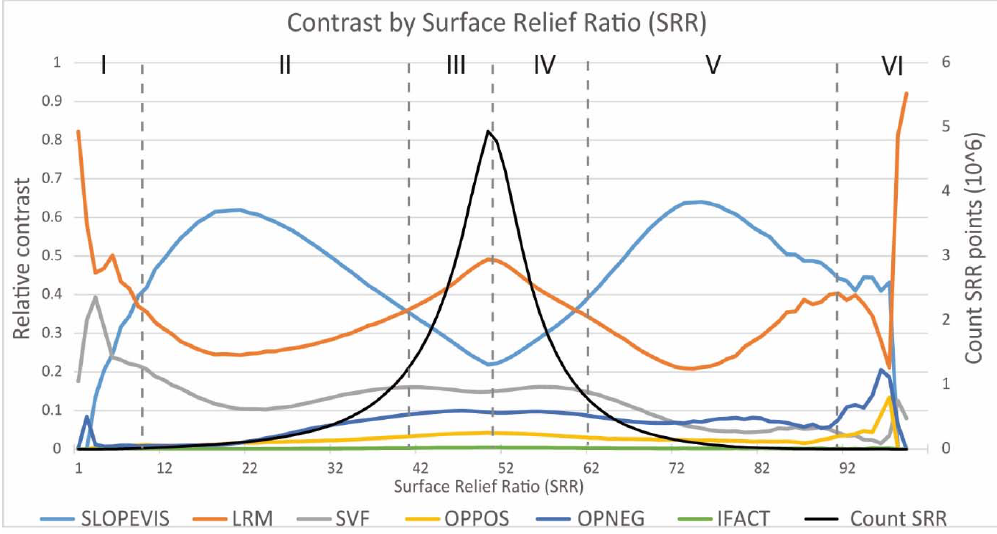
Figure A1. Contrast by Surface Relief Ratio (SRR) classes and VTs.